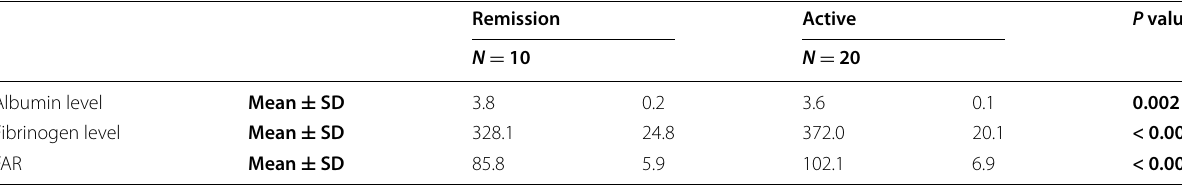
The Student t test was used for comparison P 0.05: significant; P 0.01: highly significant ≤ ≤ SD Standard deviation, FAR Fibrinogen/albumin